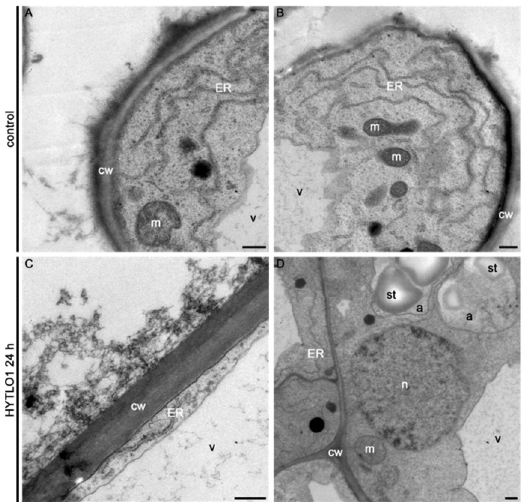
Figure 7. Electron microscopy observations of HYTLO1-treated L. japonicus cells. Cells were incubated: ( A, B ) in control conditions; ( C , D ) in the presence of HYTLO1 (0.6 µM) for 24 h. The ultrastructure of cells was found to be well-preserved even after 24 h treatment with the fungal hydrophobin. a, amyloplasts; cw, cell wall; ER, endoplasmic reticulum; m, mitochondria; n, nucleus; st, starch granules; v, vacuole. Bars, 500 nm.